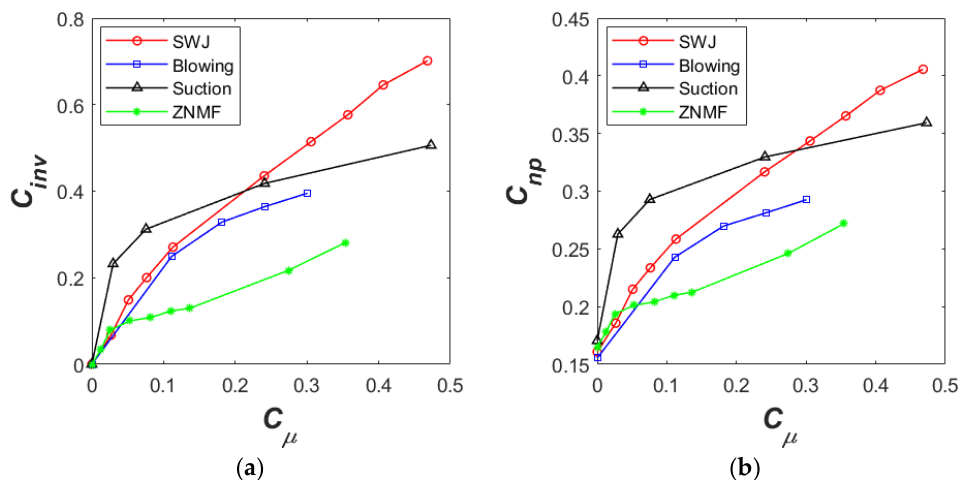
Figure 13. The performance of different AFC methods with respect to momentum coefficient: ( a ) inviscid flow comparison coefficient; ( b ) modified normal force coefficient.